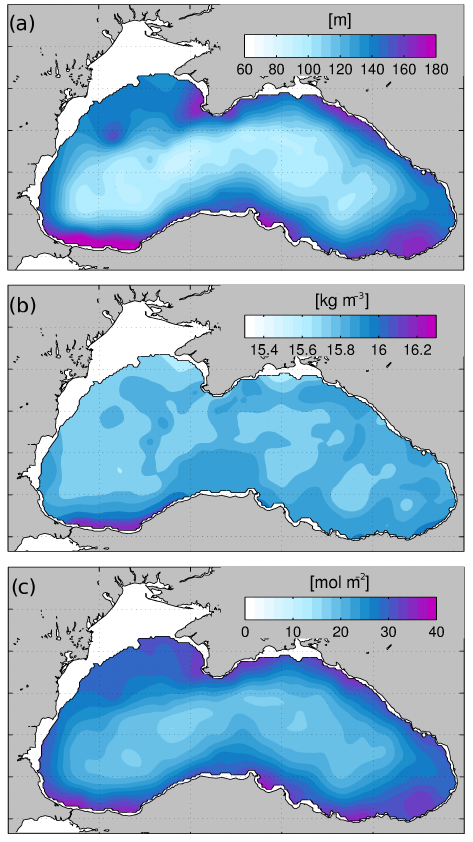
Figure 4. Annual climatologies of (a) oxygen penetration depth (where [O 2 ] = 20µM), (b) potential anomaly at oxygen penetration depth and (c) oxygen inventory. These spatial climatologies were constructed from the ship-based data set (1955–2005), accounting for the temporal variability of these diagnostics and the uneven dis- tribution of data (see Sect.